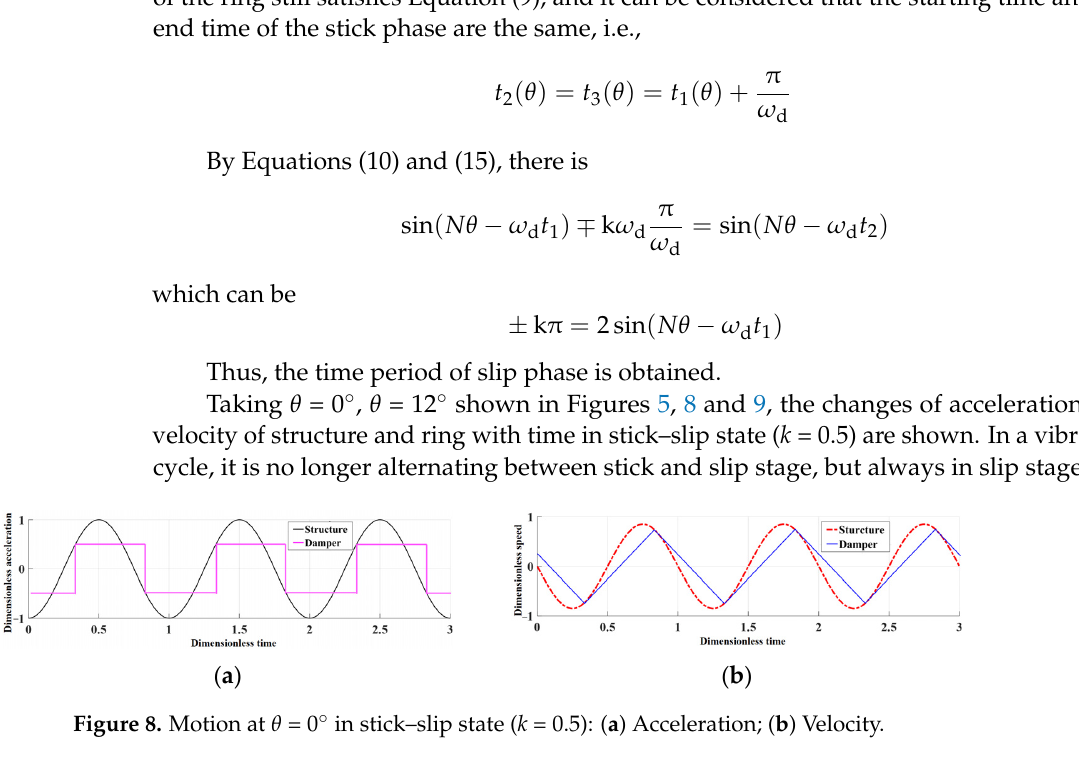
Figure 8. Motion at θ = 0° in stick–slip state ( k = 0.5): ( a ) Acceleration; ( b ) Velocity.